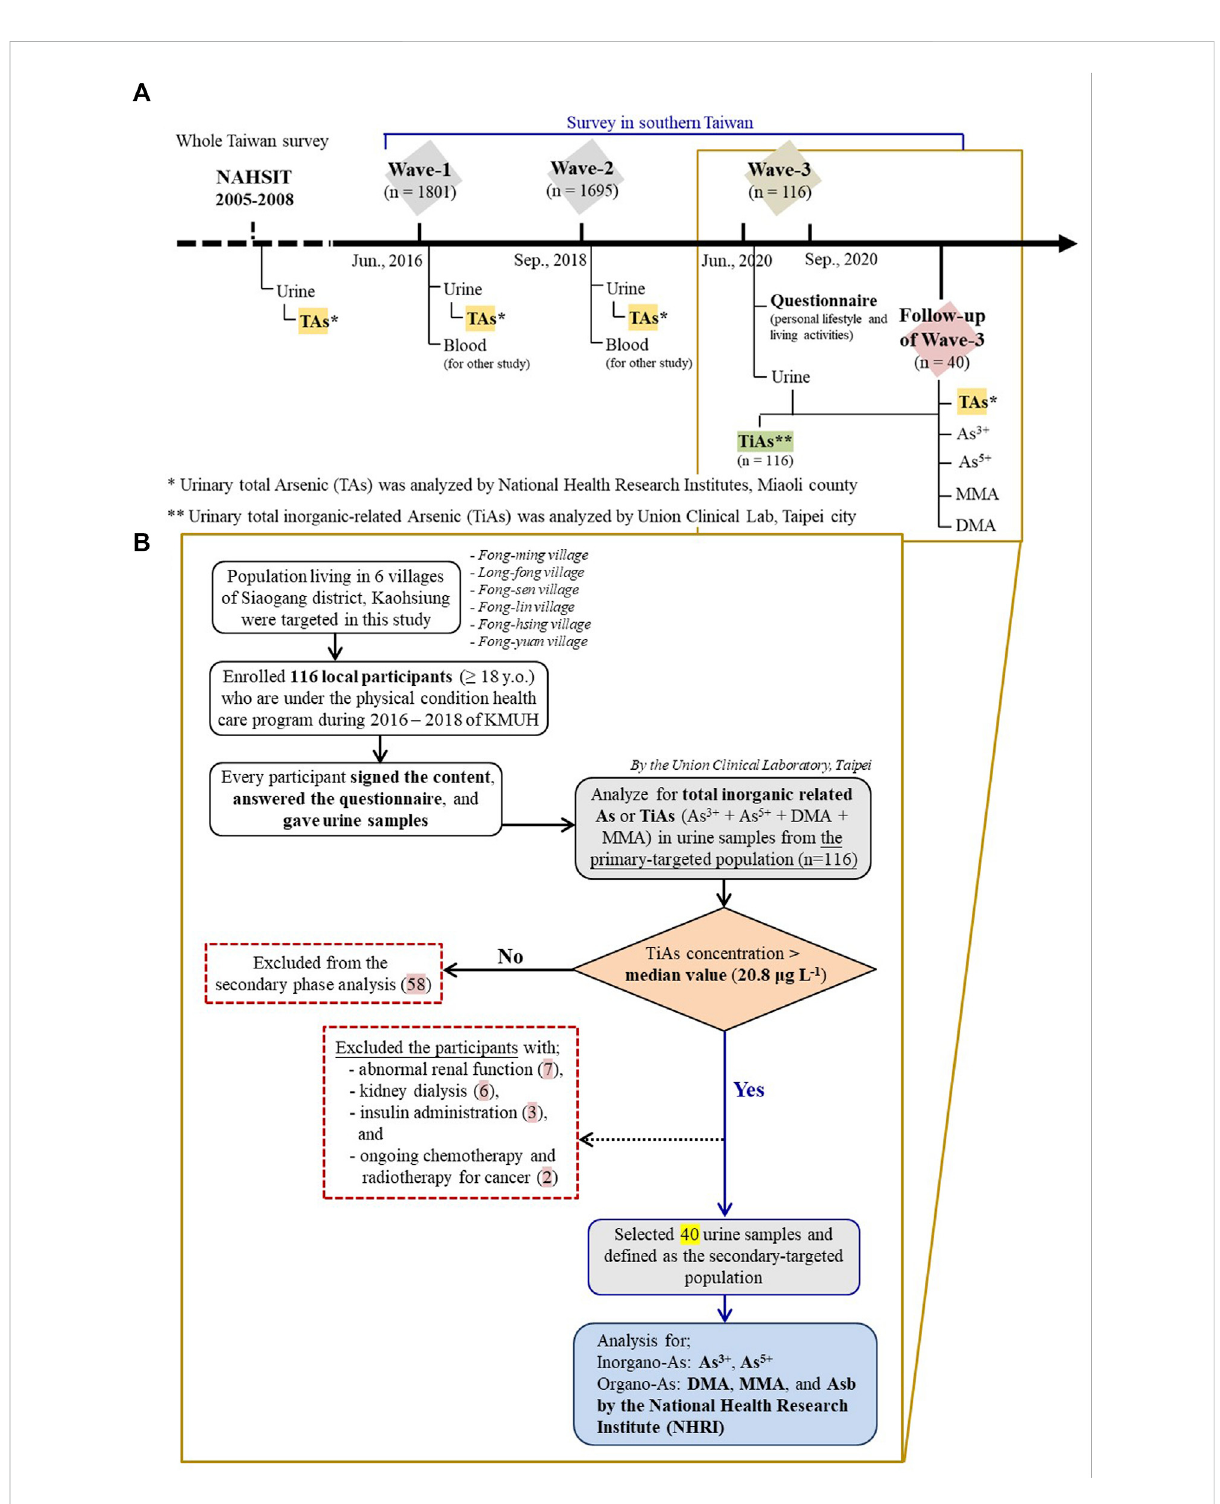
FIGURE 2 Timeline of measurement of arsenic (As) in urine in different cohorts ( ≥ 18 years old); (A) Taiwan ’ s Nutrition and Health Survey in 2005-2008 (NAHSIT 2005-8) and three survey waves (2016, 2018, and 2020) of six villages close to one coastal heavy industry in Kaohsiung city; (B) Study fl owchart of those six villages in the latest survey wave of